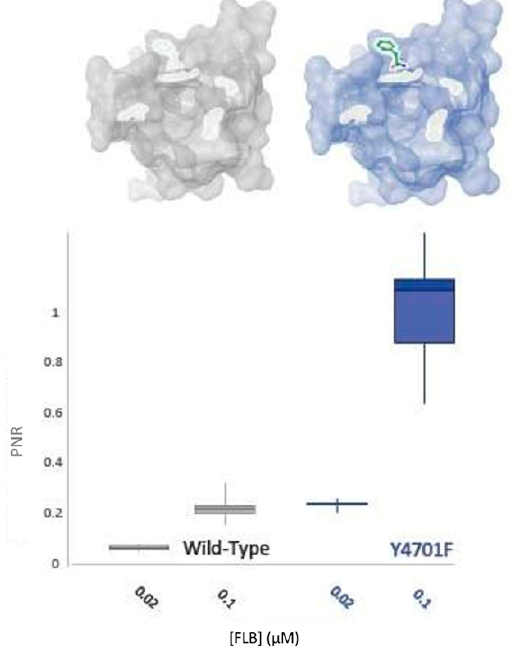
Figure 7. WT-PxRyR and Y4701F-PxRyR exhibit differing responses to low concentrations of FLB. All diamide responses are expressed as proportional normalised responses (PNRs). Error bars represent SEM.